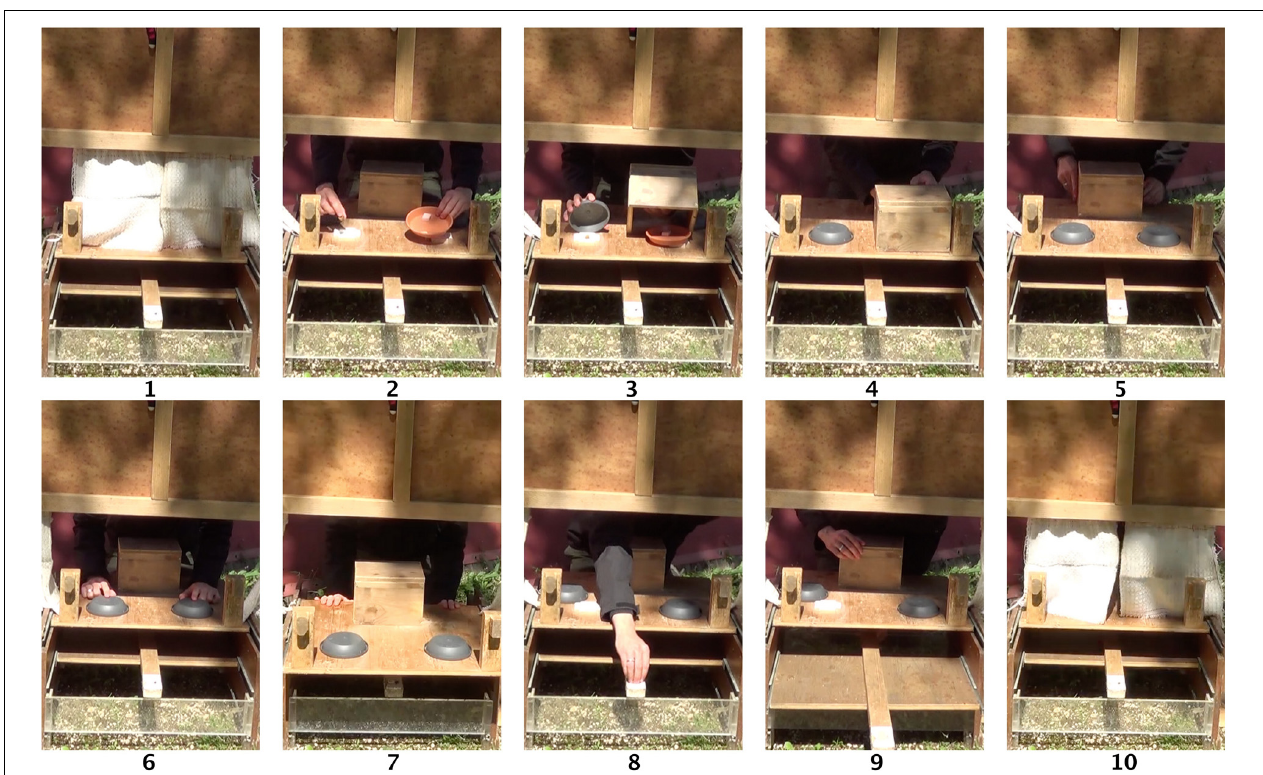
FIGURE 2 | Pictorial description of procedure from the animal’s perspective: (1) the curtain is closed, (2) the food outcomes are presented (the potential outcomes of the risky choice are both shown to the animal in the ‘outcome container,’ i.e., the brown dish), (3) the dish and barrier are placed over the food items, (4) behind the barrier the experimenter selects the appropriate outcome for the risky option unseen by the subject, (5) the identical overturned containers are presented, (6) both containers are touched simultaneously, (7) the tray is pushed forward to allow animals to choose, (8,9) the food is placed in the delivery slide and pushed forward, (10) the curtain is closed thereby ending the trial.